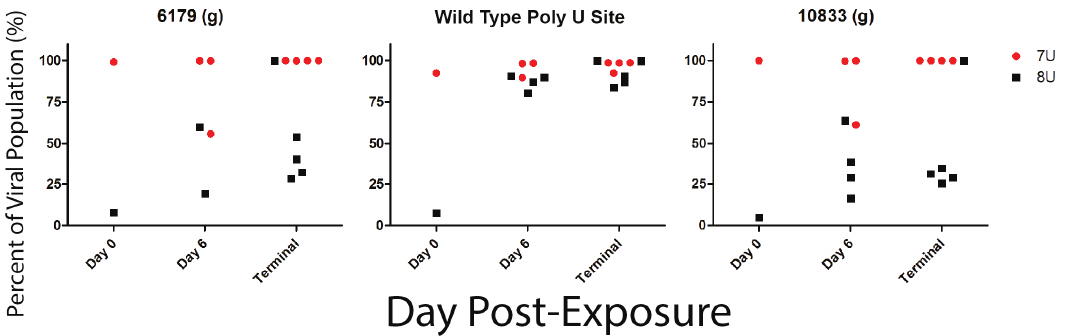
Figure 7. Viral Population Dynamics. A subset of whole blood from each cohort was sequenced to characterize changes in the whole genome over the course of infection. The number at the top of the chart indicates the sequence position, in relation to AY354458 as a reference, and the letter in parentheses represents the base at that given position. Both 6179 and 6925 positions within GP and 10833 are located in VP24. Red circles are monkeys from the 7U challenge group, while black squares represent the 8U challenge group.